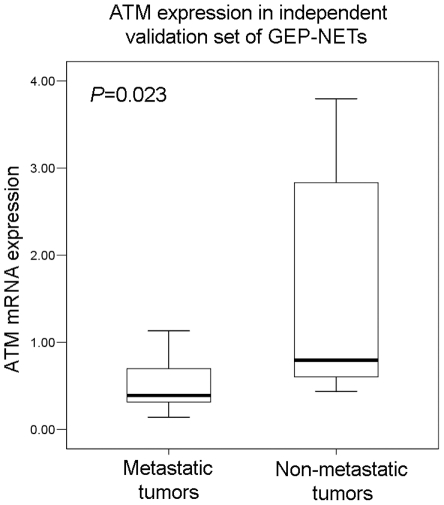
Comparison of mRNA expression levels of ATM in metastatic (mean = 0.5370±0.33263, median = 0.3912, minimum 0.14, maximum 1.13) and non-metastatic GEP-NETs (mean = 1.5075±1.22467, median = 0.7964, minimum 0.44, maximum 3.80).